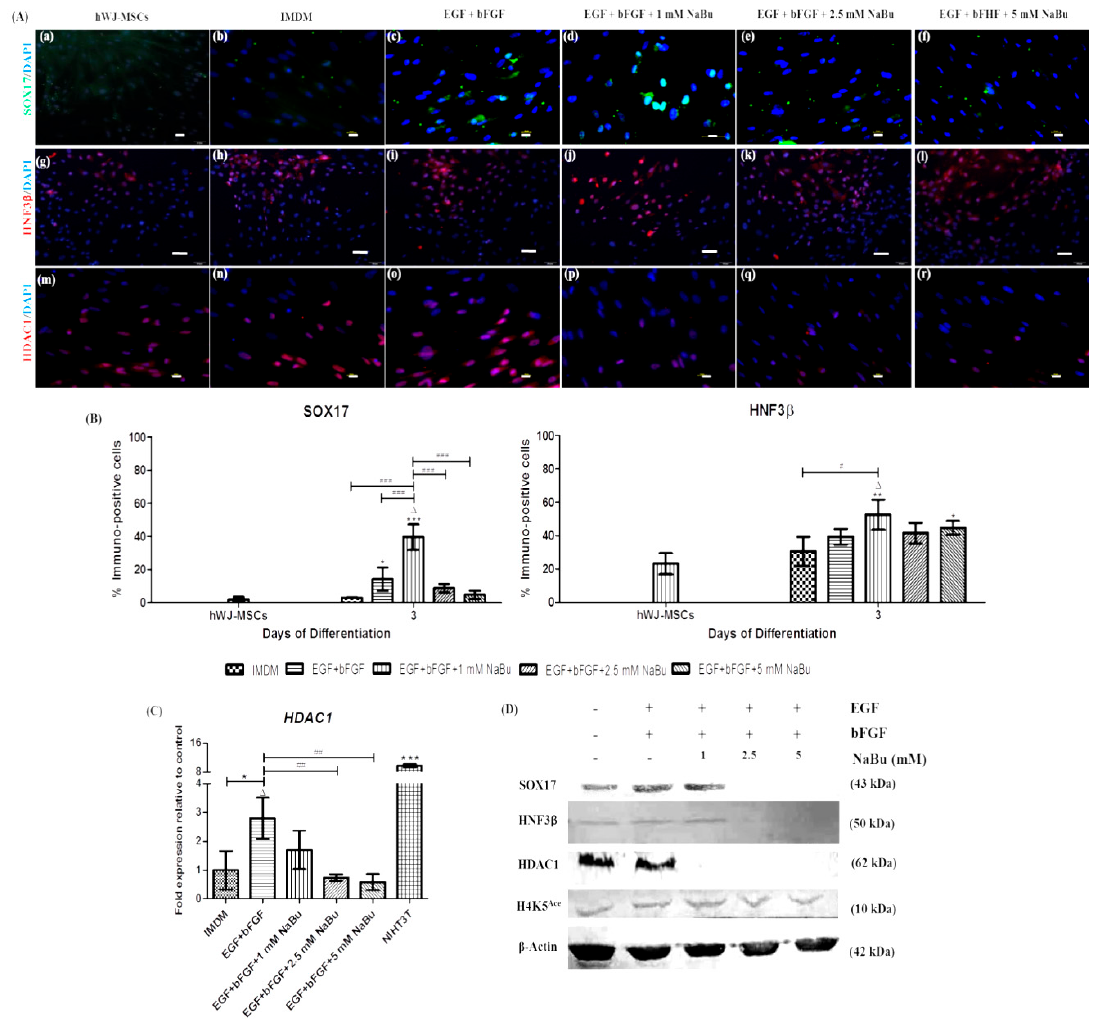
Figure 4. The influence of sodium butyrate (NaBu) along with the epidermal growth factor (EGF) and basic fibroblast growth factor (bFGF) on the definitive endodermal differentiation capacity of